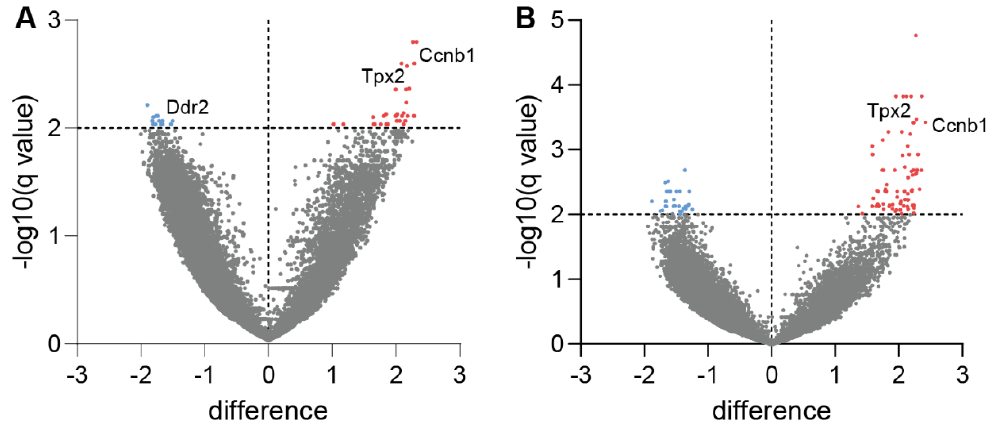
Figure 4. EGFR inhibition leads to increase in transcripts associated with higher immune cell infil- tration. ( A ) Volcano plot showing transcripts detected at significantly altered levels in lung tumour tissue from erlotinib-treated mice compared to vehicle control group. ( B ) Volcano plot showing transcripts detected at significantly altered levels in lung tumour tissue from aPD − 1 + erlotinib-treated mice compared to vehicle control group. ( A , B ) Blue points illustrate significantly downregulated transcripts, while red points indicate significantly upregulated transcripts.